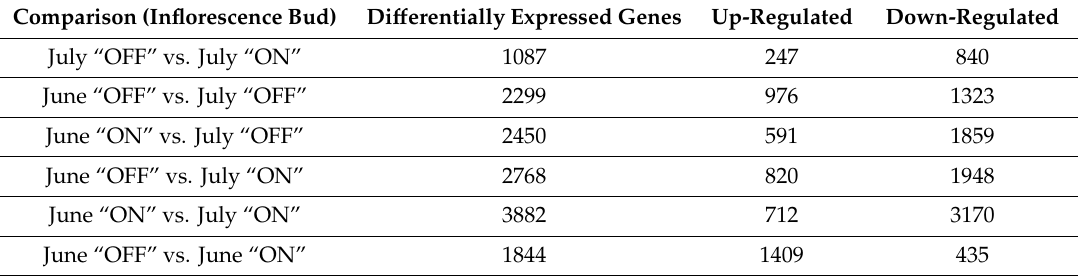
Table 1. The number of total genes, up-regulated and down-regulated genes in inflorescence buds in current year non-fruiting shoot “OFF” and in inflorescence buds in fruiting shoots “ON”. Comparison (Inflorescence Bud) Di ff erentially Expressed Genes Up-Regulated Down-Regulated